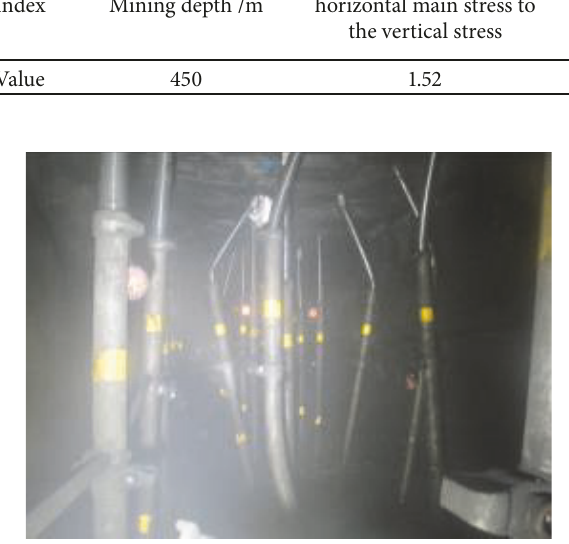
Figure 5: Hydraulic prop break in entry